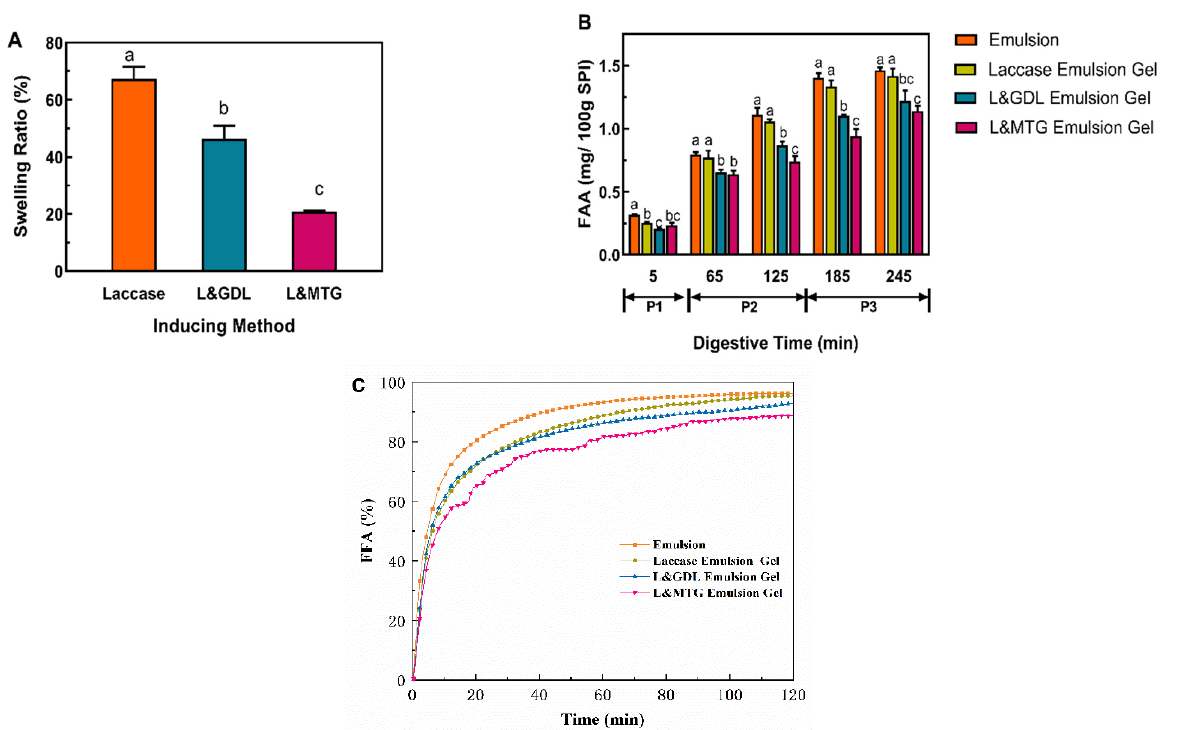
Figure 5. The swelling properties ( A ) and the digestive profiles of FAA ( B ) and FFA ( C ) for SPI-SBP emulsion gels induced by different methods. Different letters indicate significant differences in the same group at p < 0.05 level. P1: Oral Phase; P2: Gastric Phase; P3: Intestinal Phase.